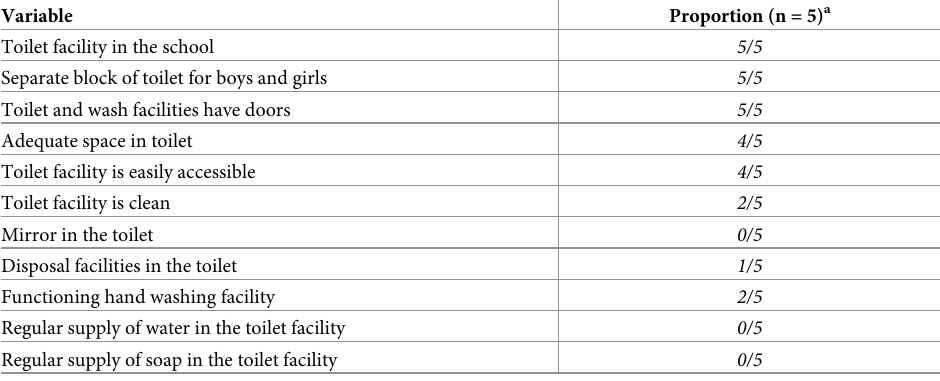
Table 6. Water, sanitation, and hygiene facilities for menstrual hygiene management in the Junior High